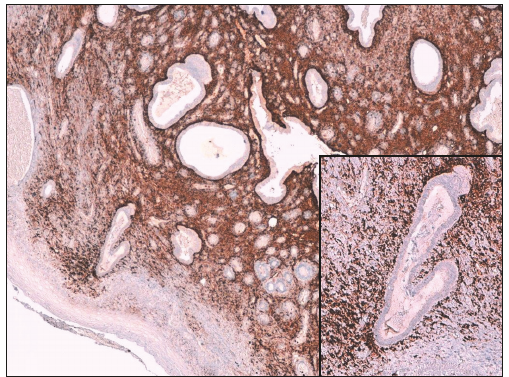
Figure 3: Blunt papillary projections are evidenced by CD10 antigen, expressed in stromal cells (CD10 immunohistochemistry × 4. Inset: CD10 ×